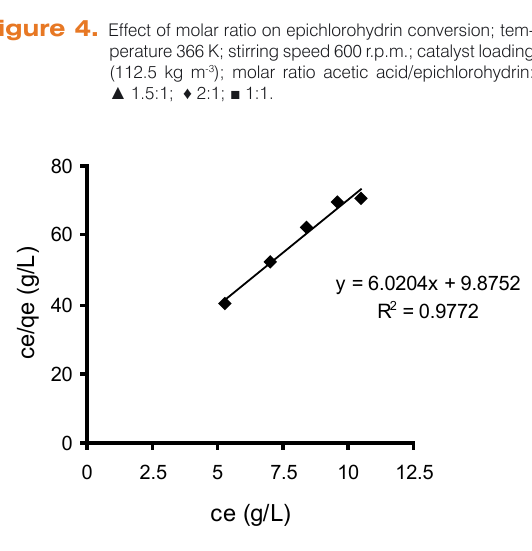
Figure 6. Plotting of Langmuir